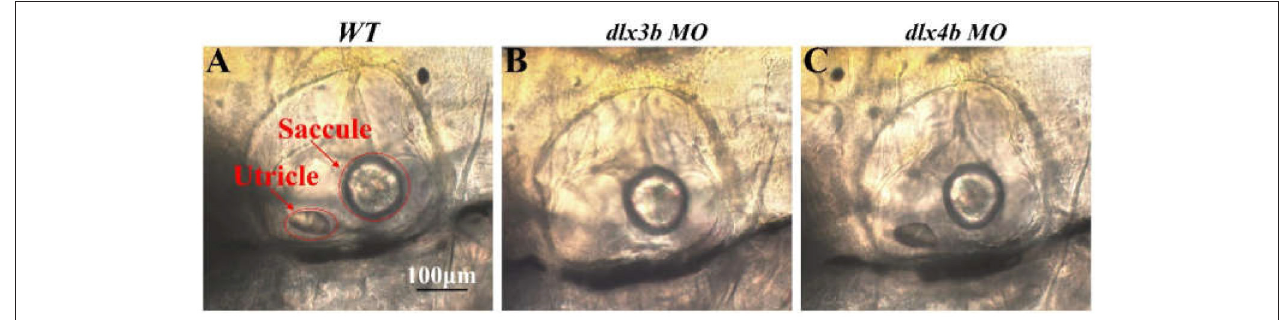
FIGURE 6 | Lateral views, anterior toward the left, of OVs in 6dpf WT, dlx3b morphant and dlx4b morphant are shown. Most dlx3b morphants lacks their utricular otolith, while dlx4b morphants retain both otoliths. Scale bars: in A , 100 µ m for A–C